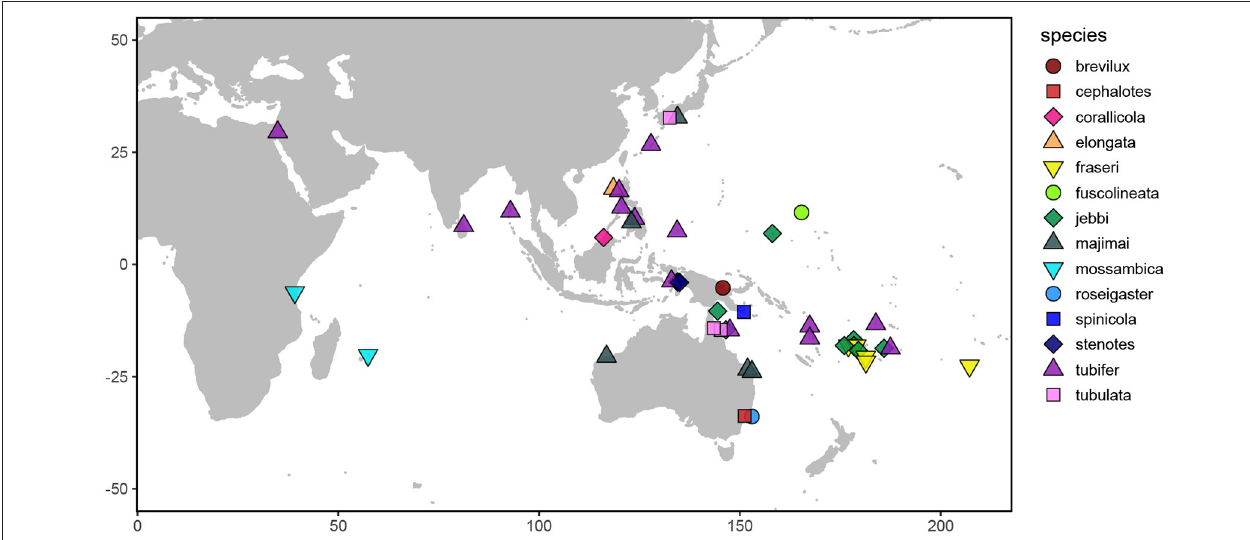
FIGURE 1 | Map depicting the sampling locations of the Siphamia specimens examined in this study. Distinct colors and shapes represent the different Siphamia species sampled as indicated in the figure legend.